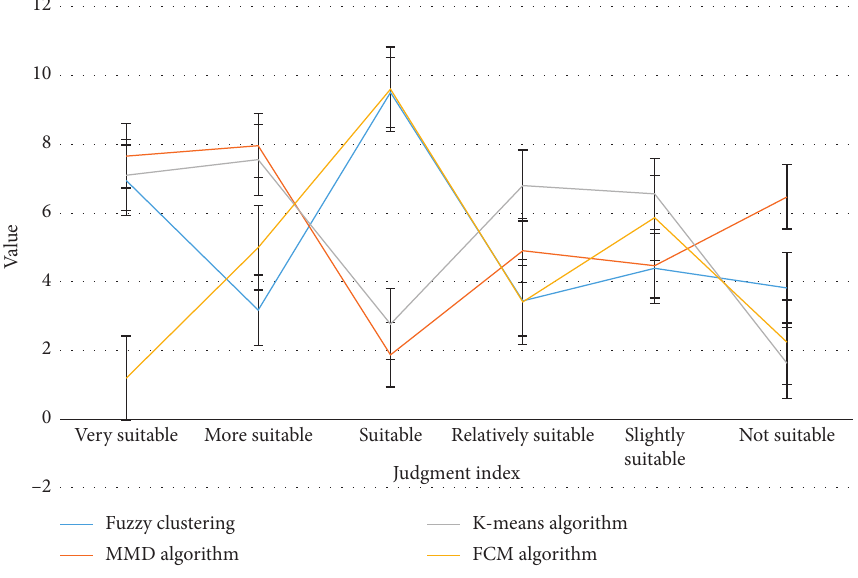
Figure 6: Judgement analysis diagram of evaluation index correlation. Table 7: Optimal routes with minimum total cost.